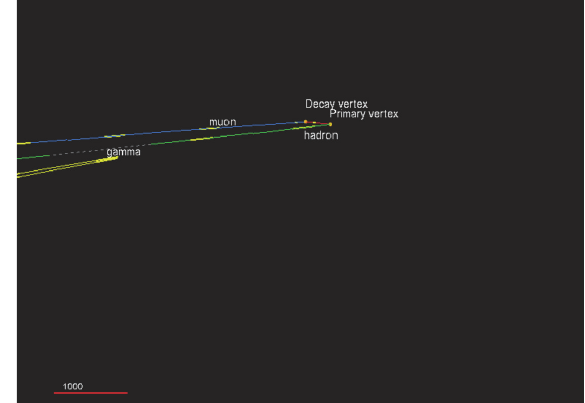
Figure 9: One of the OPERA ] 𝜏 candidates [20]. In the primary vertex the ] 𝜏 interacts producing a 𝜏 , which decays after 376 𝜇 s into a muon plus neutrinos. In addition, the conversion of a 𝛾 , produced in the primary vertex, is visible.